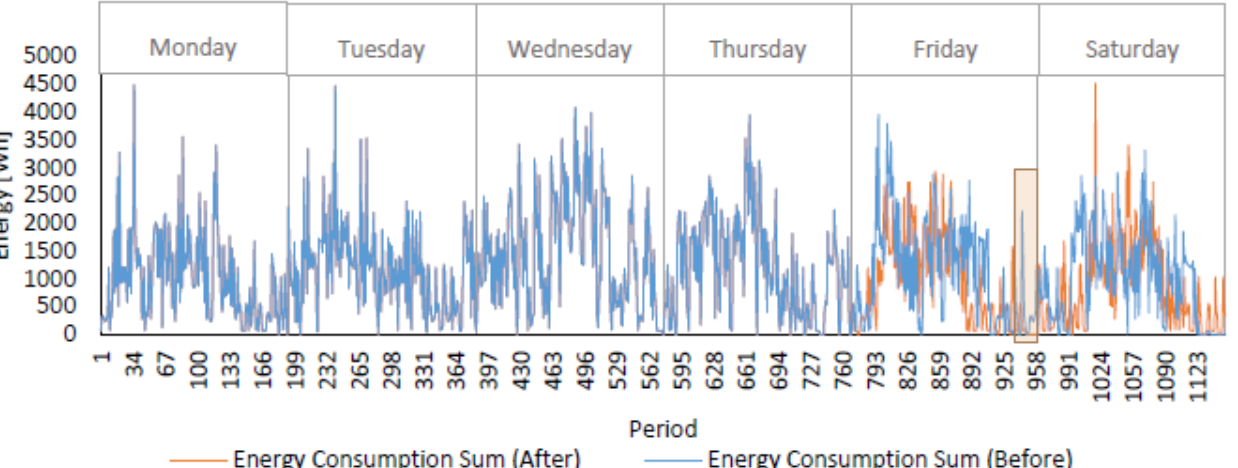
Figure 10. Energy consumption of the demand response event.